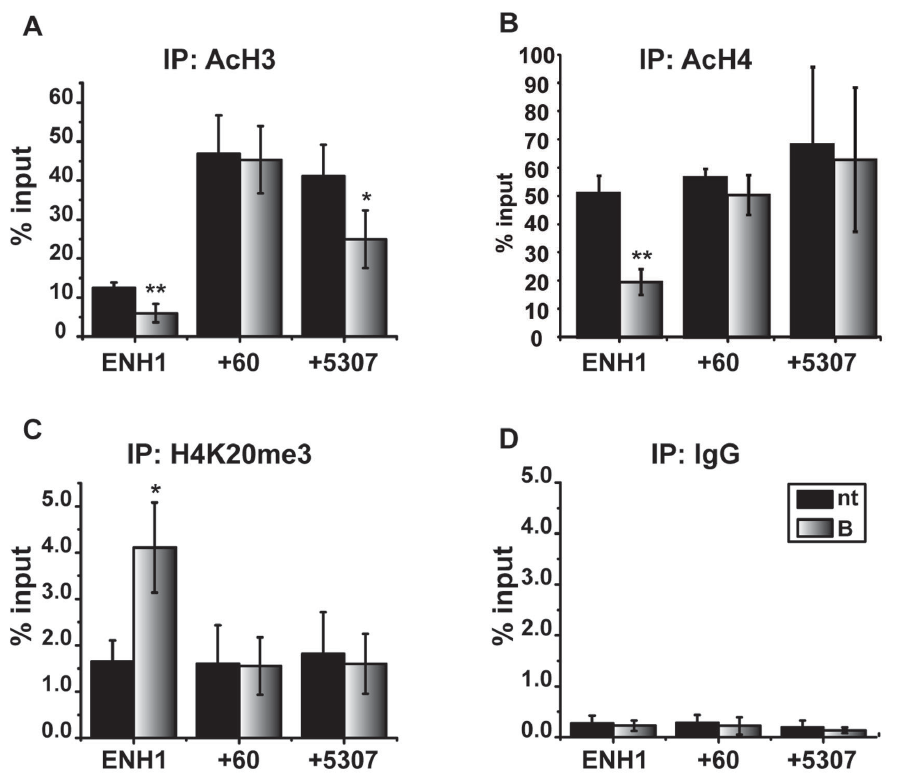
Figure 5. Proteasome inhibition decreases histone acetylation and increases H4K20me3 on the distal ESR1 enhancer. MCF7 cells were treated for 24 hours with vehicle (nt) or 30 nM bortezomib (B), and ChIP was performed as described in methods using antibodies to A ) pan acetylated histone 3 (AcH3), B ) pan acetylated histone 4 (AcH4), C ) histone 4 lysine 20 tri methylation (H4K20me3), and D ) IgG as control. Data are presented as percentage of input sample and represent a minimum of three independent experiments. Error bars indicate the SEM, and an asterisk (*) indicates a statistically significant difference between vehicle and bortezomib-treated samples using a Student’s paired t-test. * p , 0.05, ** p , .01.